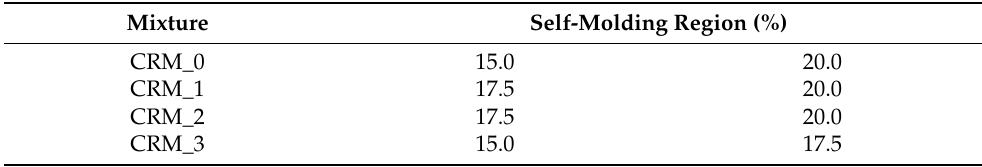
Figure 4. Results of flowability tests carried out on the CRMs. Table 4. Extreme limits of the self-molding